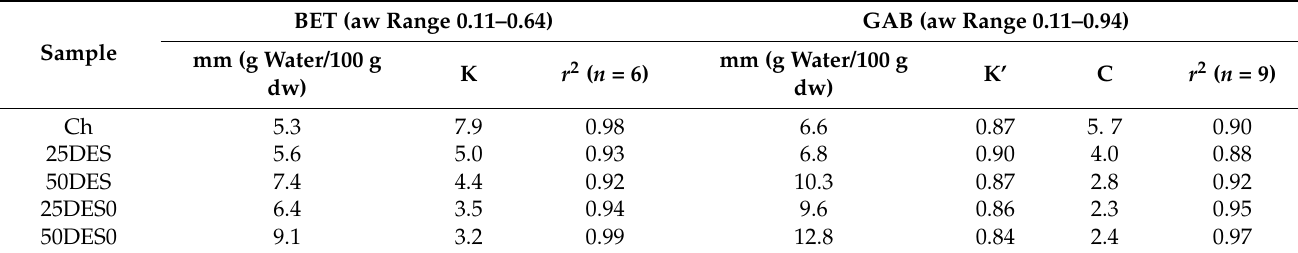
Table 4. Parameters of the BET and GAB adsorption models applied to moisture adsorption data (25 ◦ C) of chitosan and chitosan membranes spiked with the DES (25DES0, 50DES0) and the DES pomegranate peel extract (25DES, 50DES). BET (aw Range 0.11–0.64) GAB (aw Range Sample